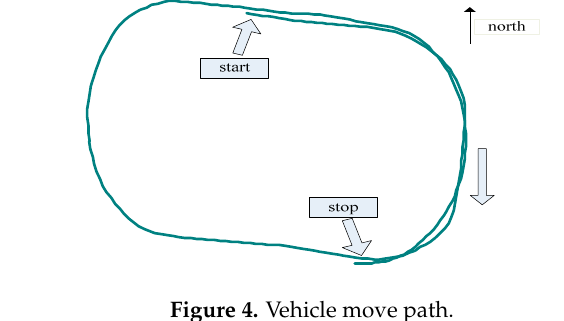
Figure 4. Vehicle move path.